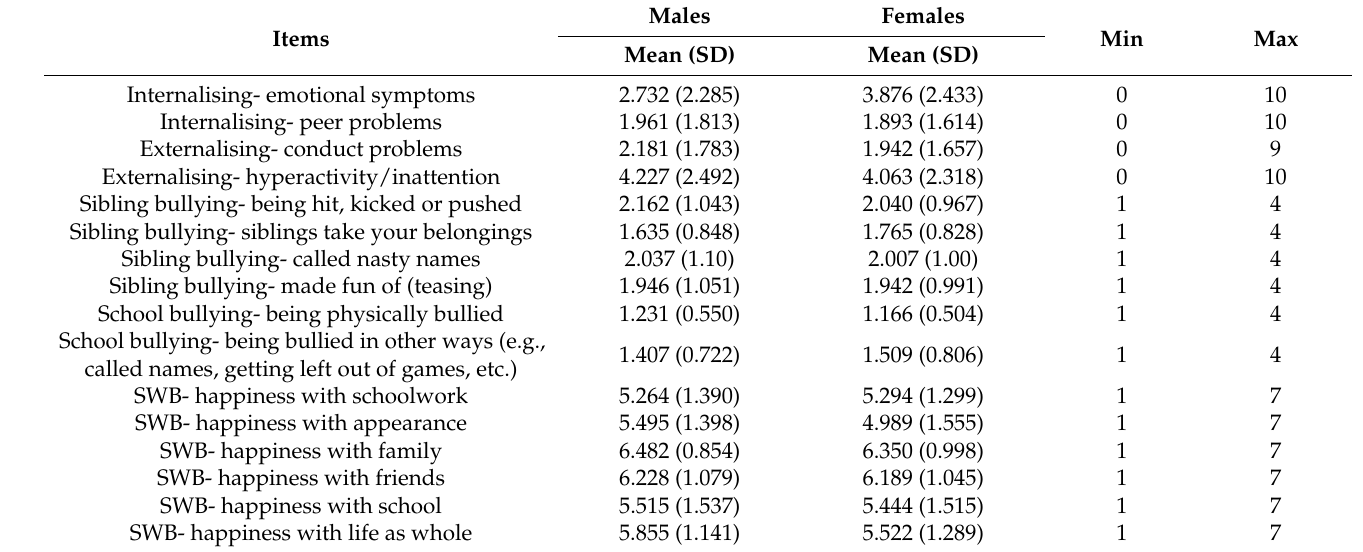
Table 1. Descriptive statistics for the whole sample (N =